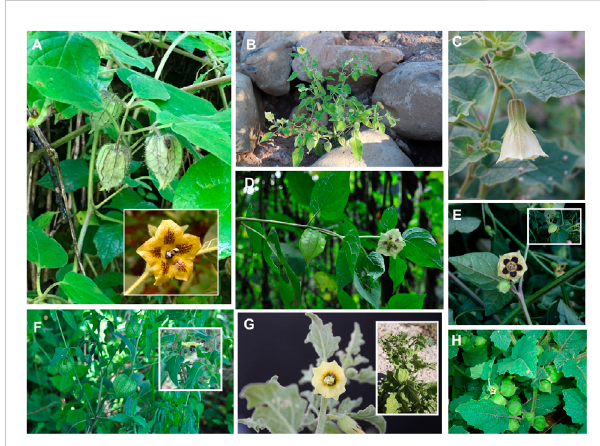
FIGURE 6 Detailsof fl owersandfruitsof Physalis spp. (A) P.coztomatl , (B) P. crassifolia , (C) P. glutinosa , (D) P. greenmanii , (E) P. gracilis , (F) P. hastatula , (G) P. hederifolia , (H) P.